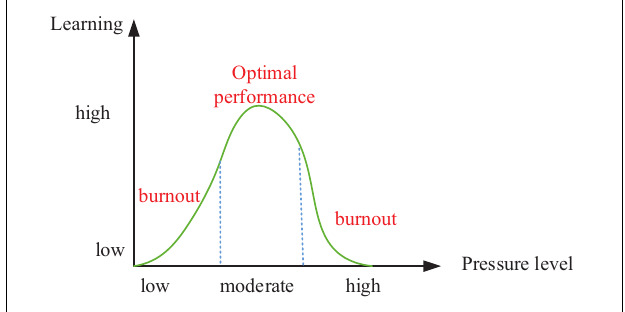
FIGURE 2 | Correlation between learning burnout and pressure